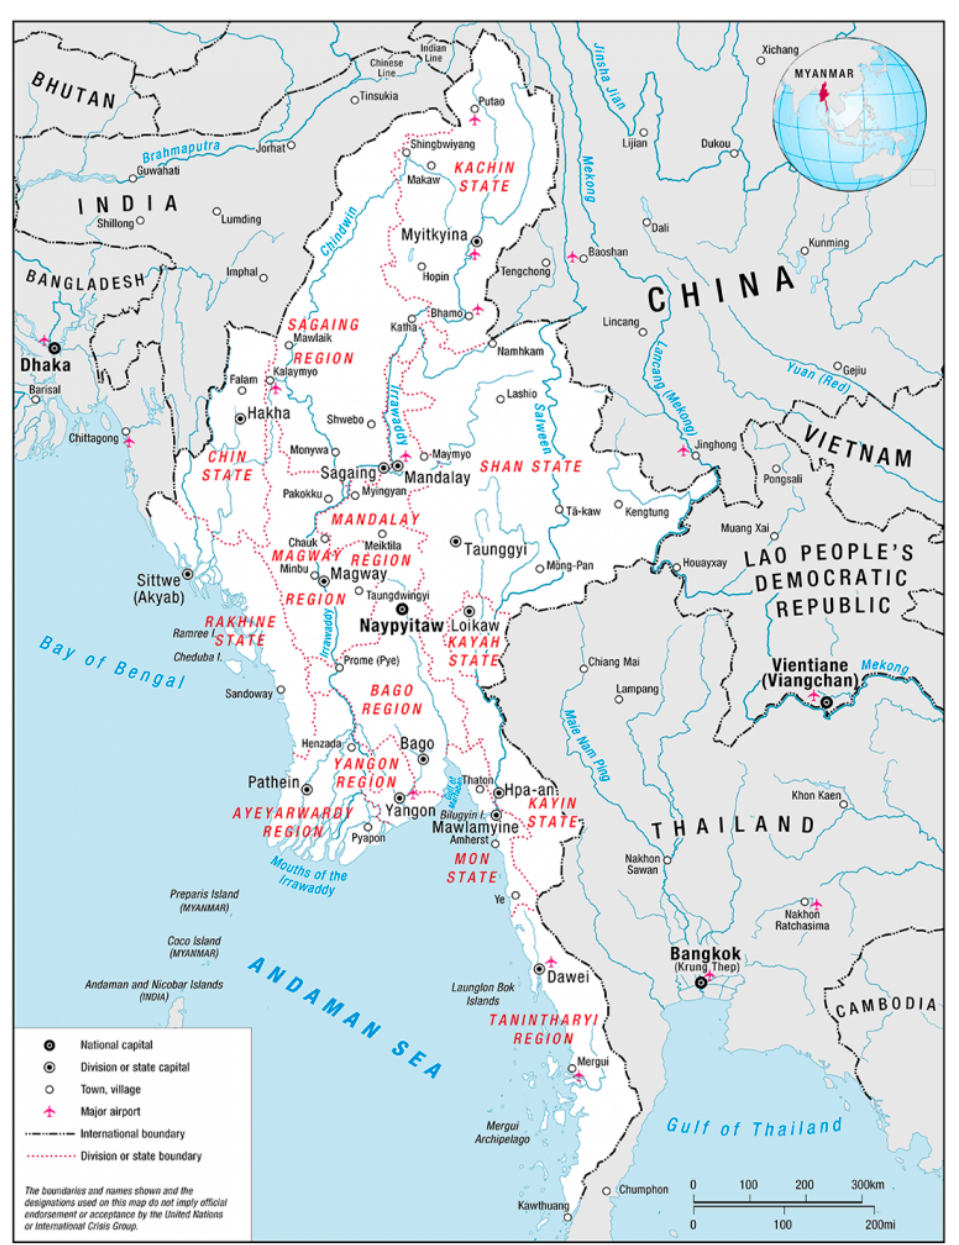
Figure A1. Political Map of Myanmar. (The map shows Myanmar and surrounding countries with international borders, the national capital Naypyitaw, state/division boundaries and major airports.)